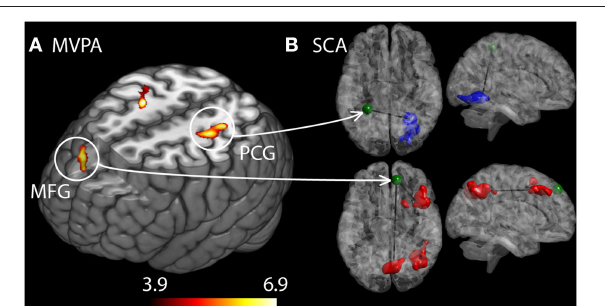
FIGURE 2 | Differences in brain connectivity profile indexed at a voxel level using multivariate pattern analysis (MVPA). (A) Brain regions that are significantly different between the RA and the HC cohorts with regard to connectivity profiles. Colorbar indicate F-statistic of between group differences with regard to the spatial maps of the three first principal components. Three clusters were identified: in left middle frontal gyrus (MFG) and in left and right post central gyrus (PCG). The F-maps are threshold at a p < 0.05 FDR corrected cluster level, using an explorative voxel level threshold of p < 0.01 . (B) Post-hoc SCA using seed regions defined as spheres placed at the peak coordinates from MVPA, identified RA increased functional connectivity between MFG and premotor areas as well as a cluster spanning the precuneus and somatosensory areas (red clusters). HC displayed stronger connectivity between left PCG and contralateral associative visual